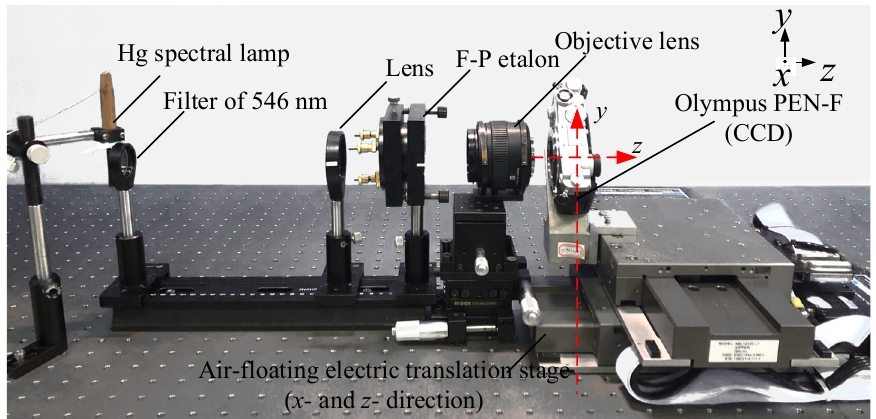
Figure 8. Experimental setup for microdisplacement.